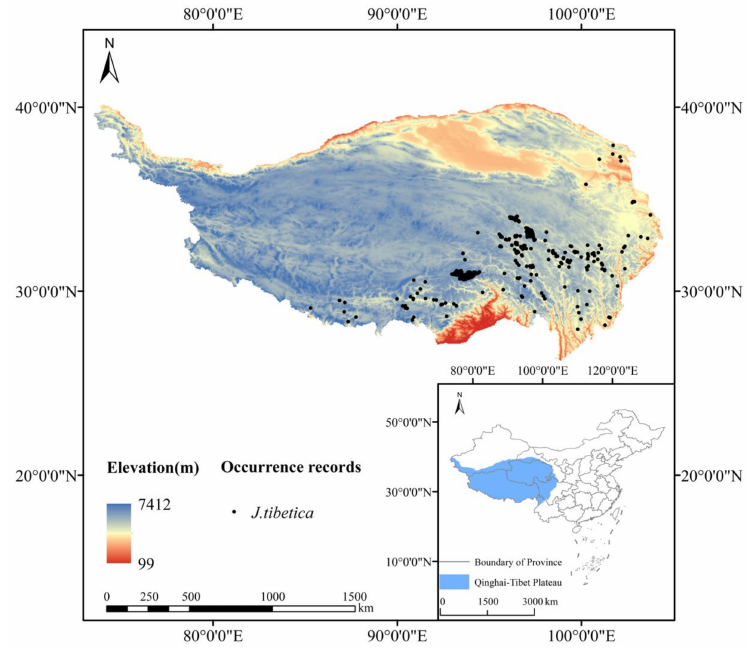
Figure 1. Distribution points of J. tibetica on the QTP. Table 1. Implication of environment variables used in the